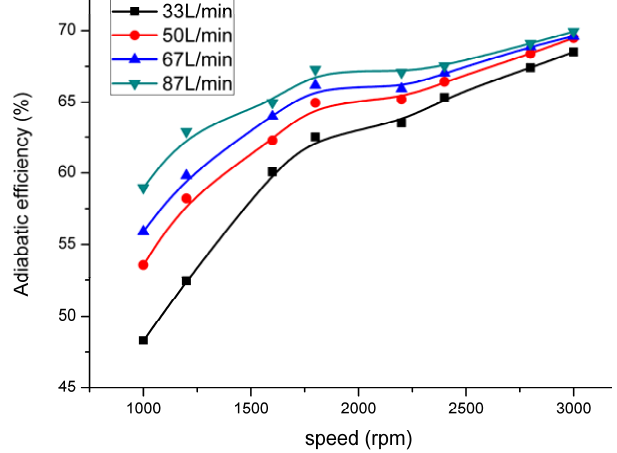
Figure 7. Variation of adiabatic efficiency under different rotational speeds.